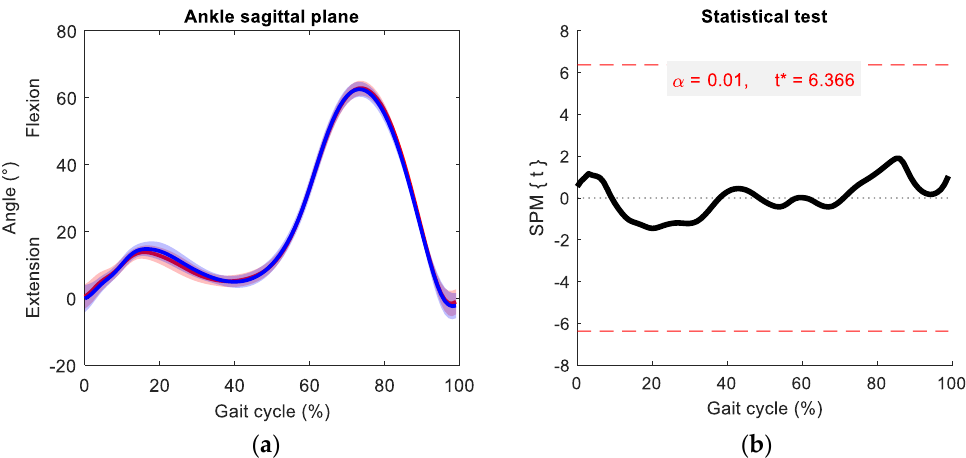
Figure 8. ( a ) Mean sagittal knee angle during gait cycle from heel strike to heel strike with (red) and without (blue) exosuit, and ( b ) statistical 1D SPM test; * critical t-value.